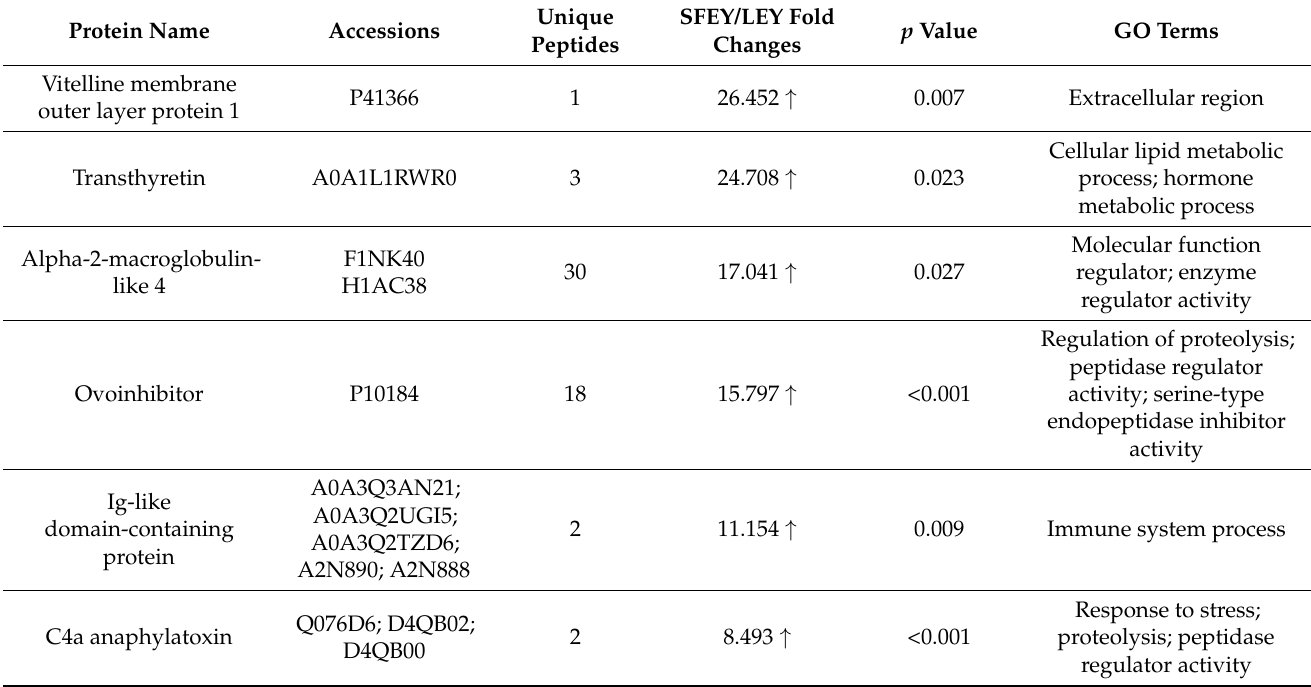
Table 1. List of significantly differentially abundant proteins in SFEY versus